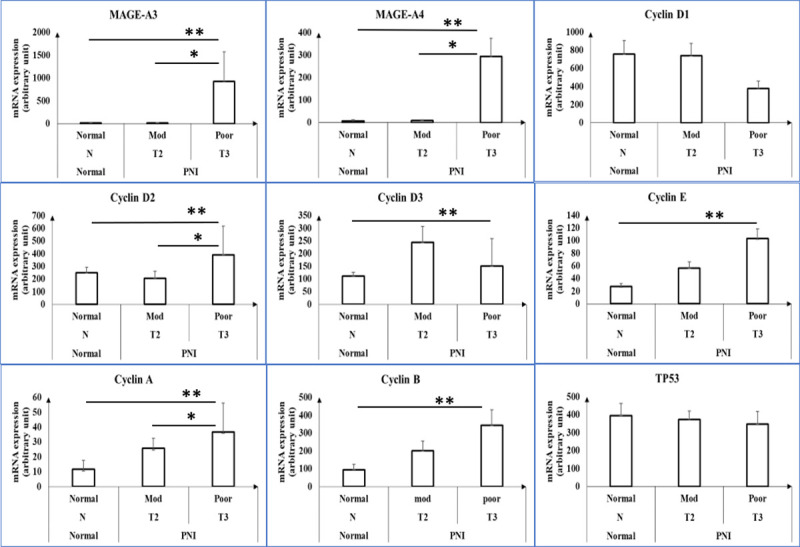
Expression of MAGE-A3, MAGE-A4 and cyclins mRNA in normal skin and cSCC tumors with PNI.Expression levels of MAGE-A3, MAGE-A4, cyclin D1-3, cyclin E, cyclin A, cyclin B and p53 mRNA in normal skin tissues (n = 7), cSCC tumors with PNI and moderate differentiation (n = 6), and cSCC tumors with PNI and poor differentiation (n = 3) as assessed by Nanostring analysis. Group names are listed on the x-axis based on BWH tumor stage and tumor differentiation. Mod = moderate differentiation; Poor = poor differentiation; N = normal; T2 and T3 = BWH tumor stage. * and ** represent p<0.05.